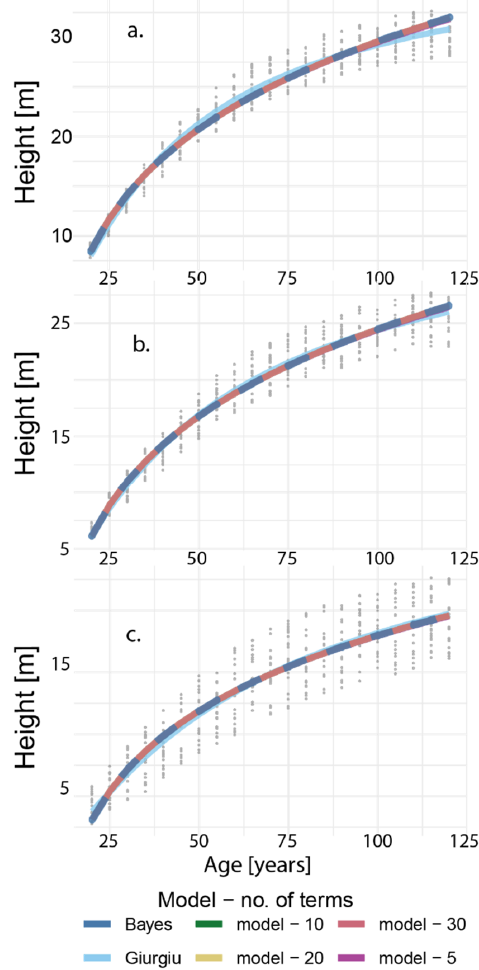
Figure 9. Site index modeling for the Norway spruce. An efficient Taylor series expansion contains at most 30 terms, irrespective of site productivity: a. class II (SI = 31.8 m) b. class III (SI = 26.9 m) c. class IV (SI = 21.9 m). The difference between the Bayesian models and the one based on Taylor series expansion is so minute that is visually undistinguishable . Table 2. Comparison of the site index models for the Norway spruce (index age 100 years).